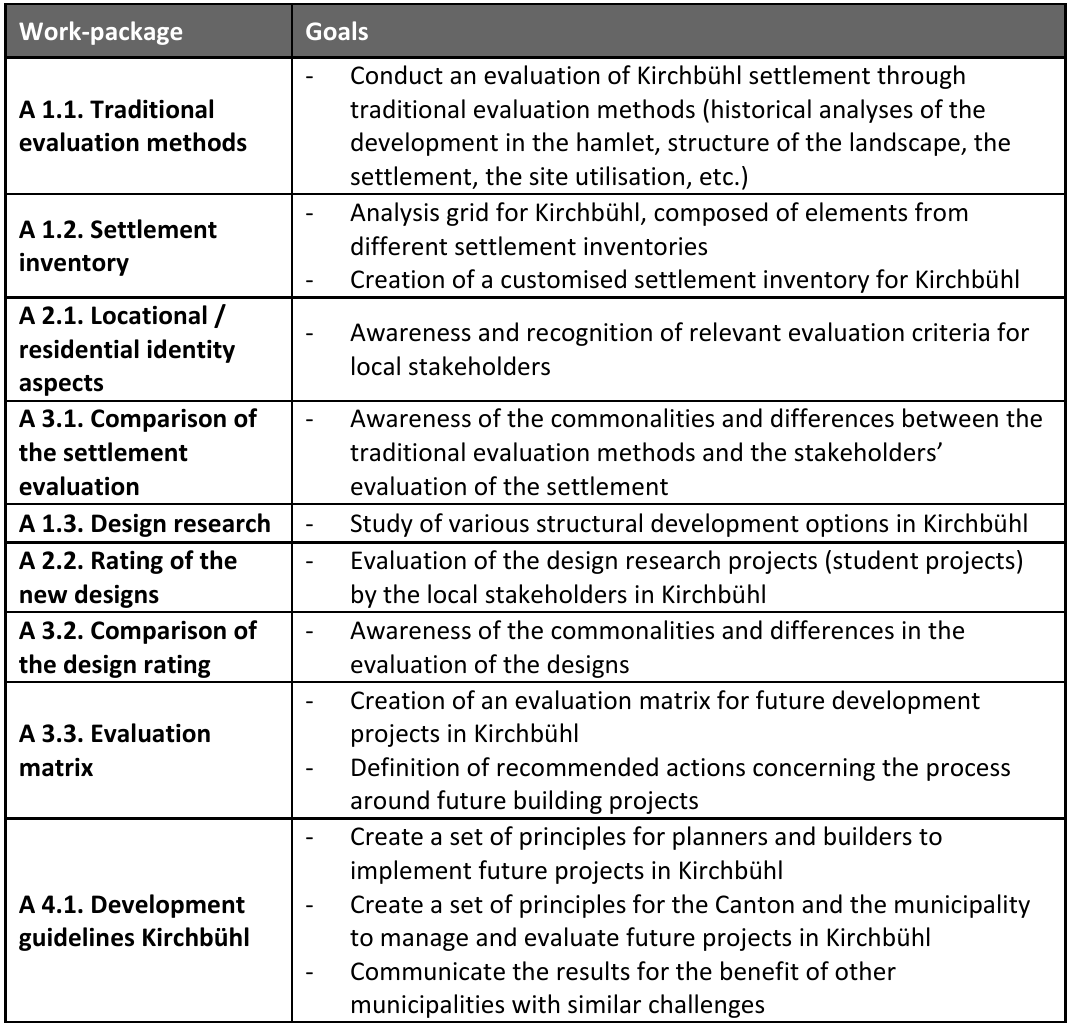
Table 1: Project work-packages and associated goals